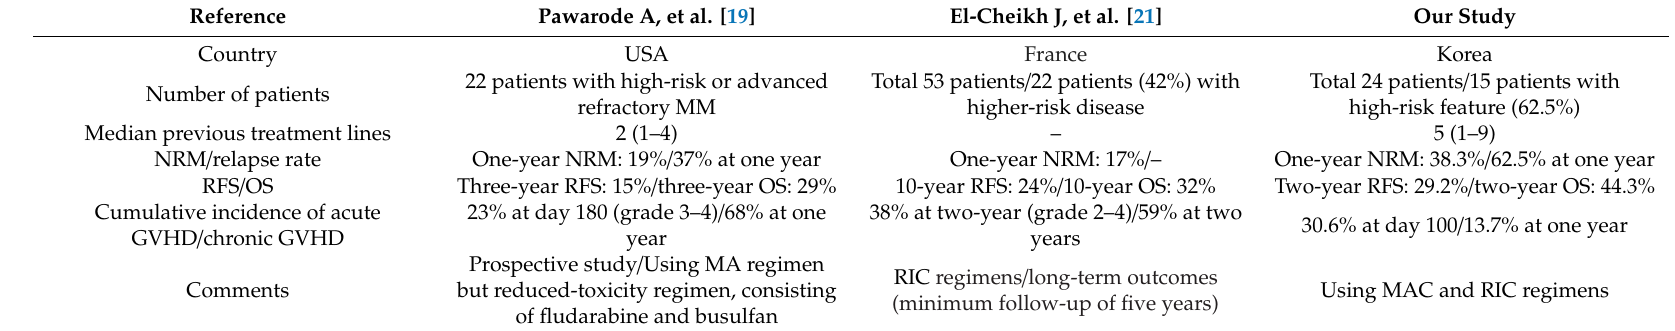
Table 5. The comparison with previous